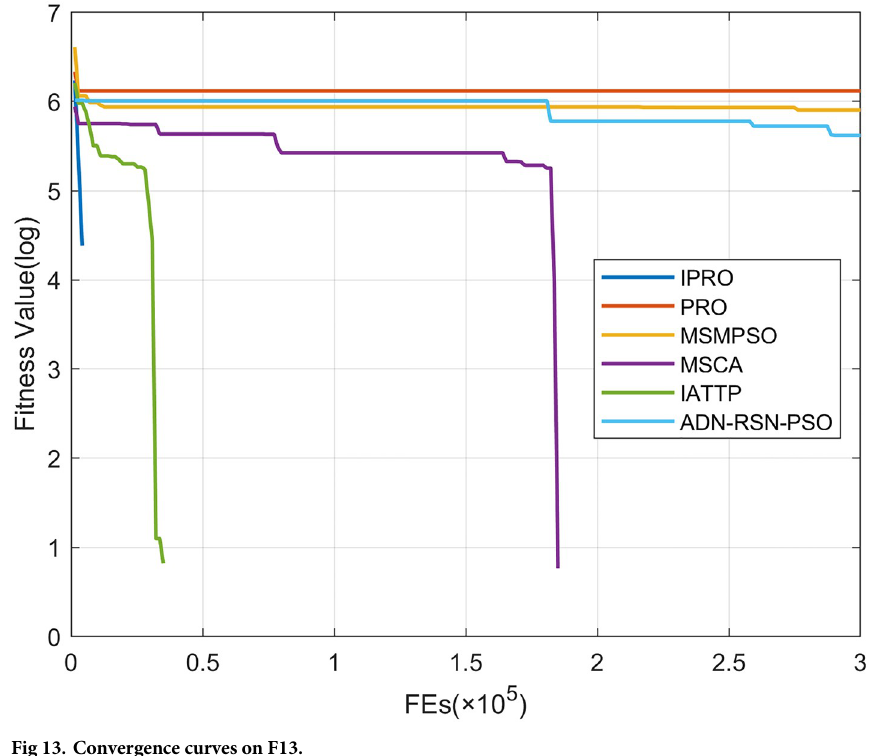
Fig 13. Convergence curves on F13.